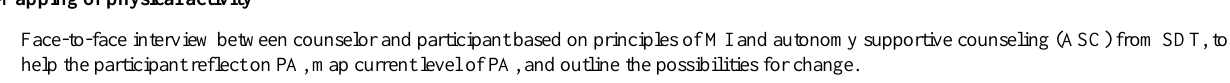
Goals and plan for physical